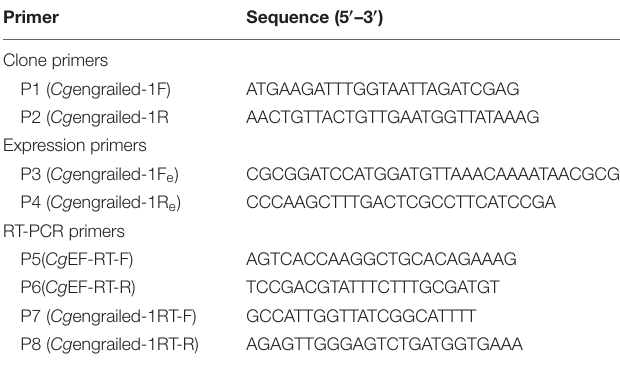
TABLE 1 | Sequences of the primers used in this